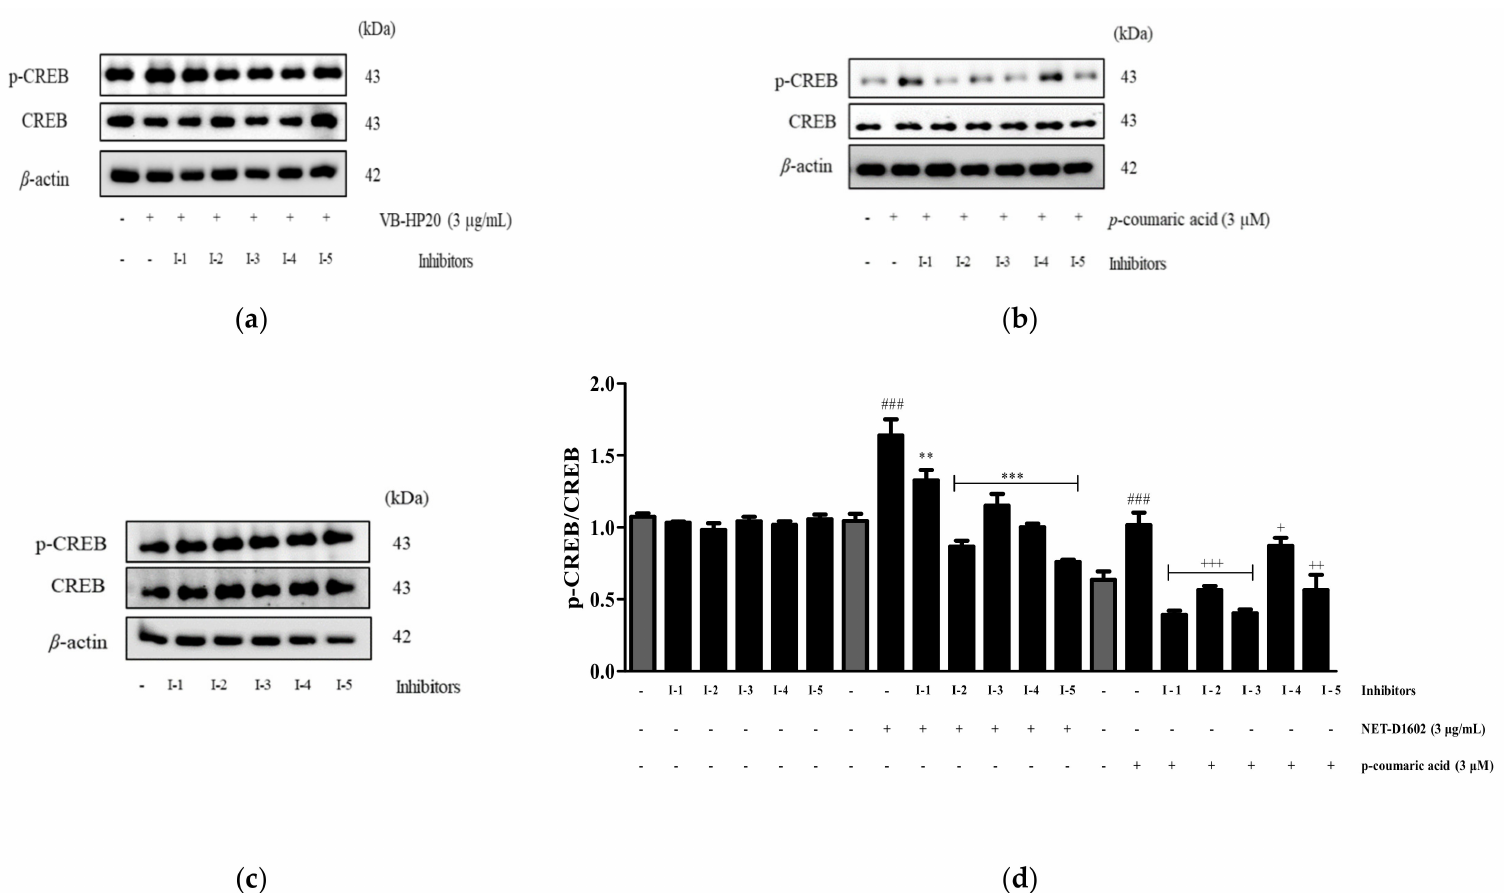
Figure 6. Effects of NET-D1602 and p -coumaric acid on CREB phosphorylation in primary cultured rat cortical neurons. Primary cultured cortical neurons were pretreated with kinase inhibitors for 2 h and subsequently treated with ( a ) NET-D1602 and ( b ) p -coumaric acid for 30 min, and cell lysates were analyzed by using Western blotting. ( c ) Primary cultured cortical neurons were treated with kinase inhibitors for 2 h. ( d ) Quantitative analysis of relative CREB phosphorylation level normalized to β -actin level. ### p < 0.001 compared to that of the untreated group; ** p < 0.01, and *** p < 0.001 compared to that of the NET-D1602 group; + p < 0.05, ++ p < 0.01, and +++ p < 0.001 compared to that of the p -coumaric acid group. CREB, cyclic AMP-responsive element-binding protein; I-1, wortmannin; I-2, PD98059; I-3, rapamycin; I-4, H89; I-5, ZM336372; NET-D1602, HP-20 resin fraction of the water extract of Vaccinium bracteatum